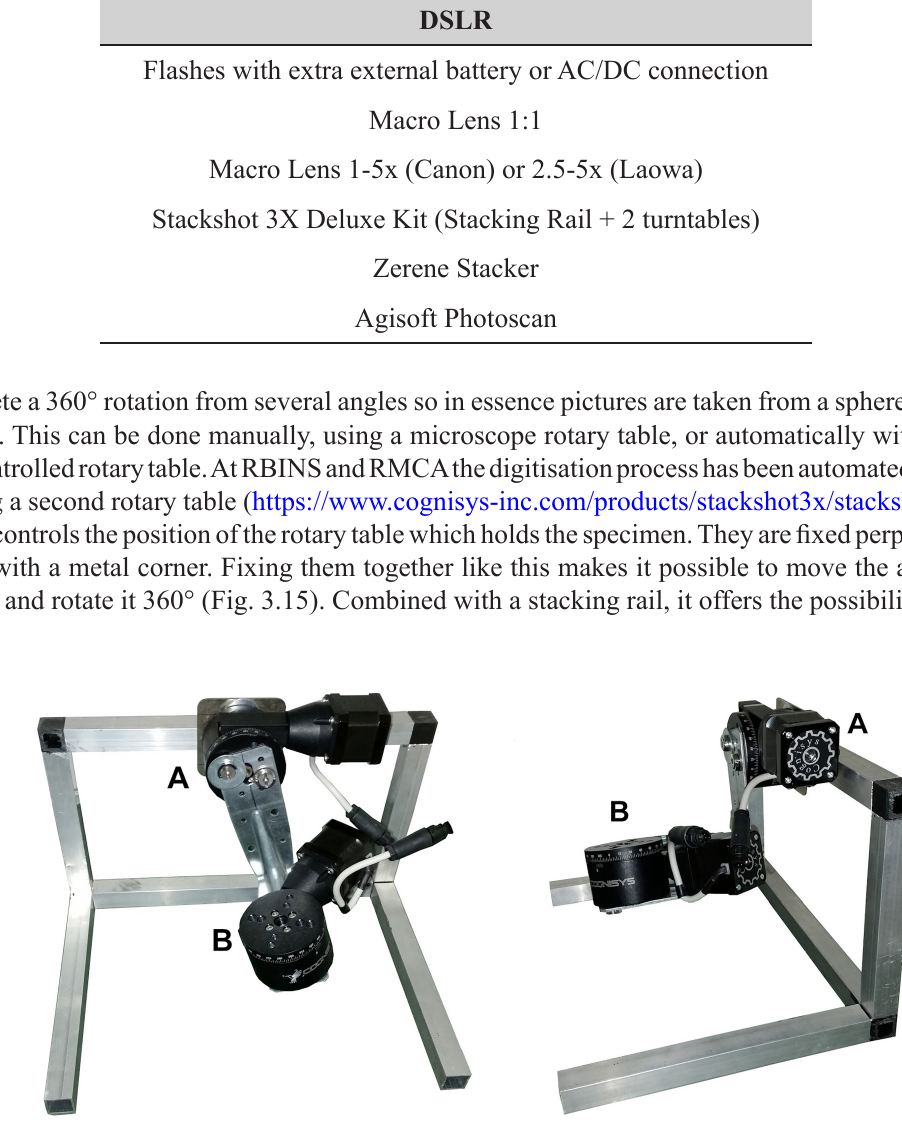
Fig. 3.15. Part of the Cognisys StackShot 3X Deluxe Kit, reassembled for the photogrammetry purpose. The two rotary tables are mounted perpendicular to each other, whereby rotary table A moves a steel angle with rotary table B fixed at the